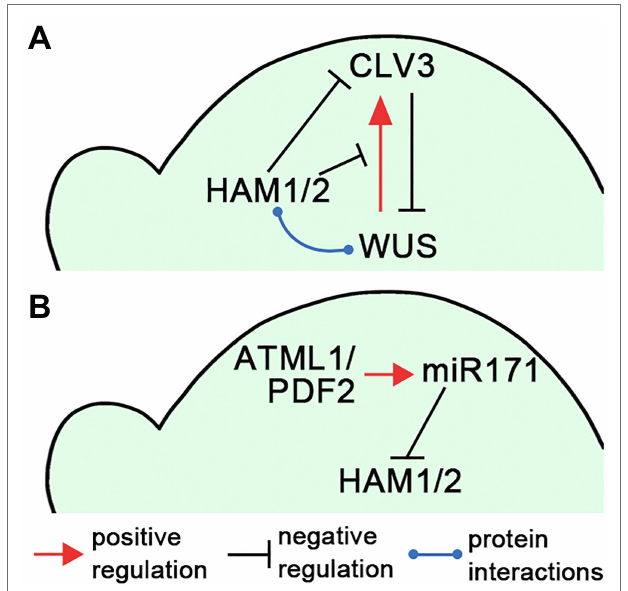
FIGURE 2 | Illustrations of the HAM regulatory circuits in SAMs. (A) A diagram illustrates that HAM1/2 sustain the WUS-CLV3 feedback loop in Arabidopsis SAMs. (B) A diagram illustrates the L1(ATML1/PDF2)-miR171- HAM signaling cascade, which shapes HAM1/2 expression patterns in Arabidopsis SAMs. The positive and negative regulations and protein–protein interactions are indicated in (A,B)